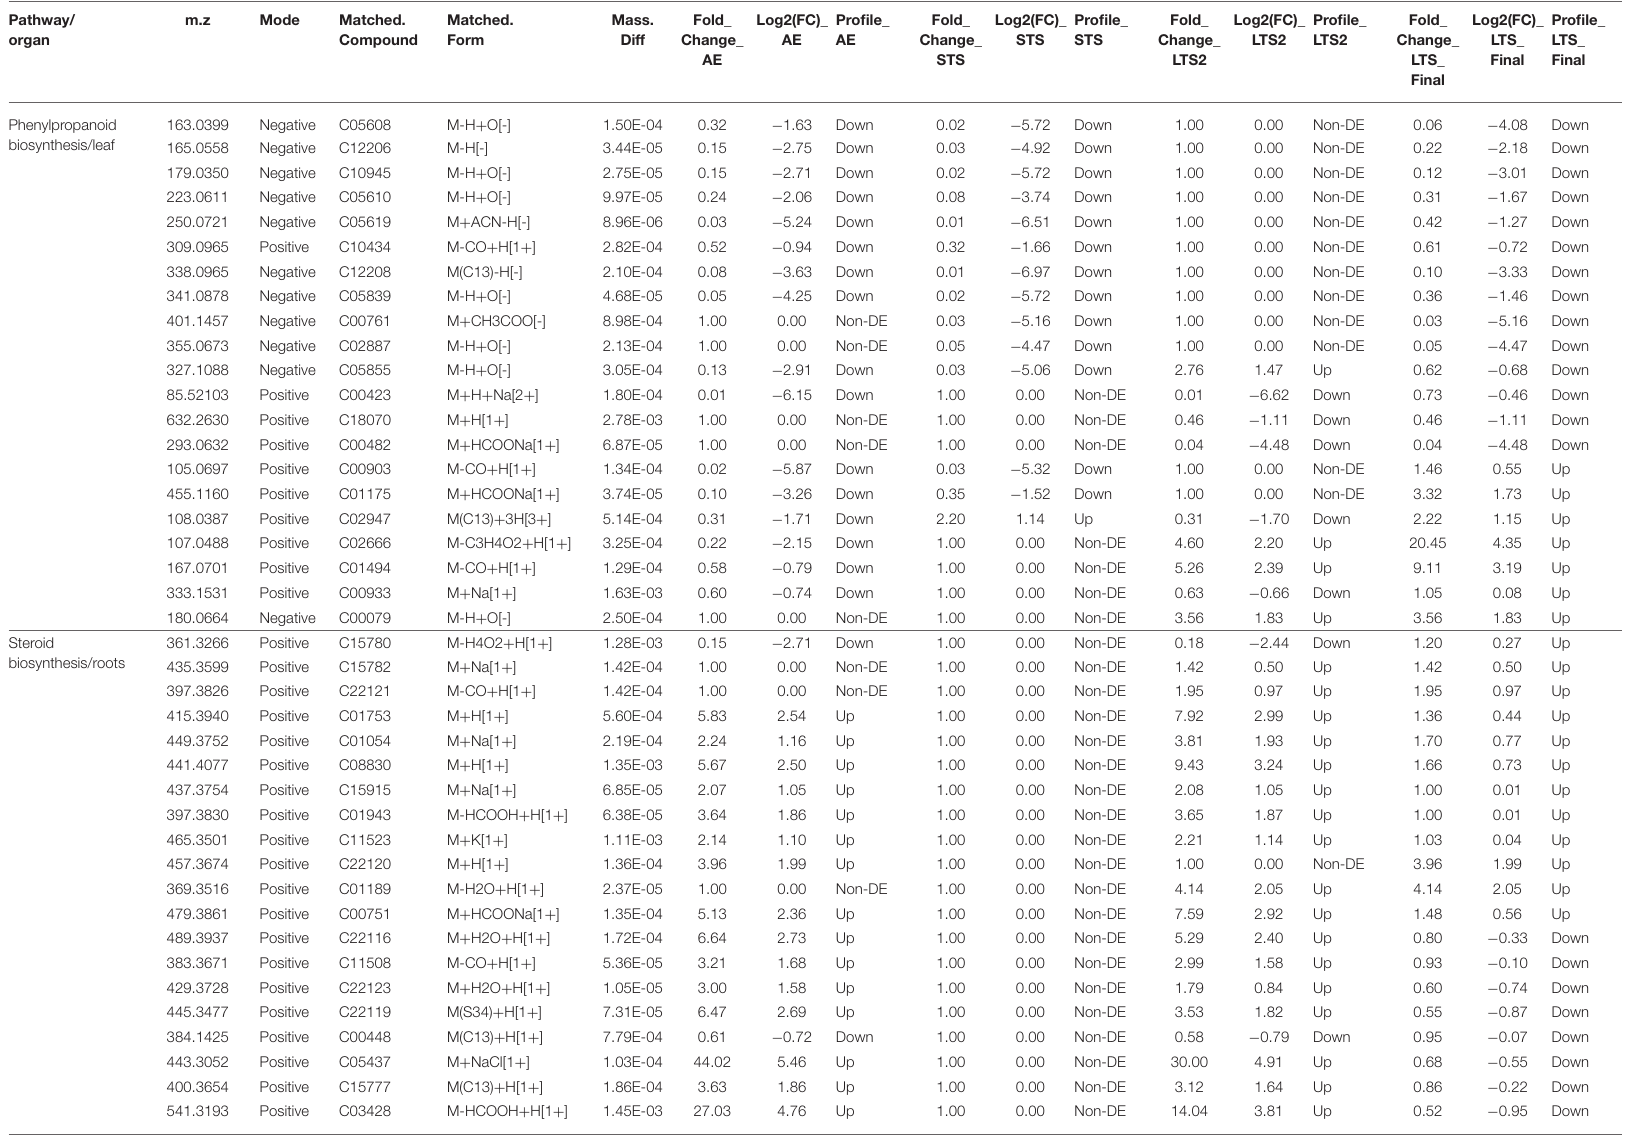
TABLE 2 | Differentially expressed peaks and features from the phenylpropanoid biosynthesis pathway (leaves), steroid biosynthesis (roots), and lysine biosynthesis (roots), in gliricidia plants submitted to salinity stress in three distinct scenarios: age effect—AE (control plants at 2 and 55 days under salinity stress—DAT), short-term stress—STS (control and the stress plants at 2 DAT); and long-term stress 2—LTS2 (stressed plants at 2 and 55